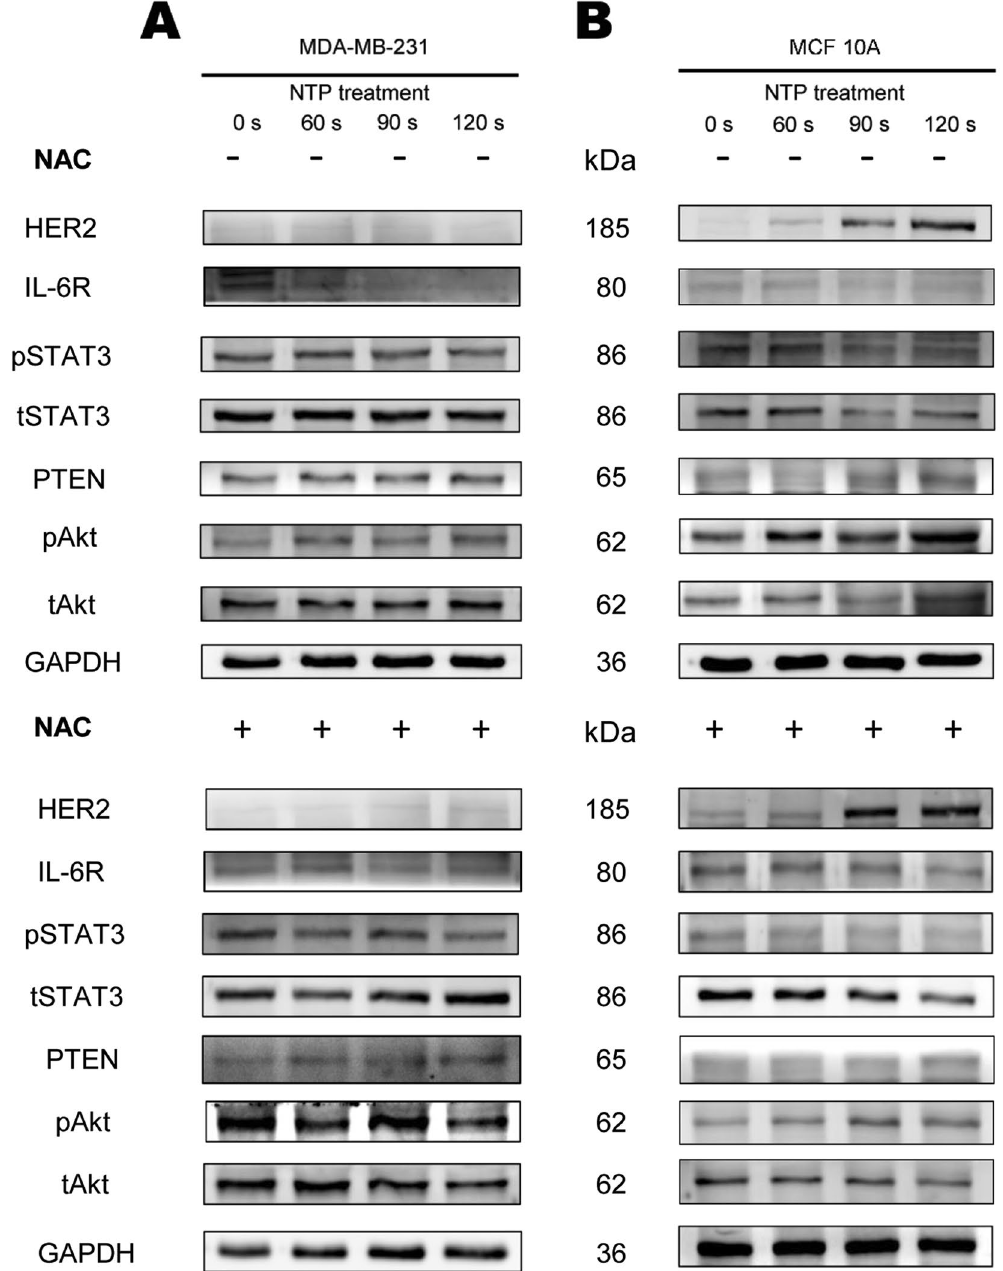
Figure 6. Effects of NTP on the IL-6R/pSTAT3 and HER2/pAkt pathway in MDA-MB-231 and MCF10A cells. MDA-MB-231 ( A ) and MCF10A ( B ) cells were exposed to NTP for 0, 60, 90 or 120 s. After forty-eight hours post-treated with 5 mM N-acetyl cysteine (NAC + ) or without (NAC − ), proteins from total cell lysates were harvested. The expressions of HER2, L-6R, pSTAT3, tSTAT3, PTEN, pAkt and tAkt were detected by Western blot analysis. GAPDH was taken as a loading control throughout. The gels/blots were processed under the same experimental condition. Cropped gels/blots are displayed and full-length blots/gels are presented in Supplementary Figure